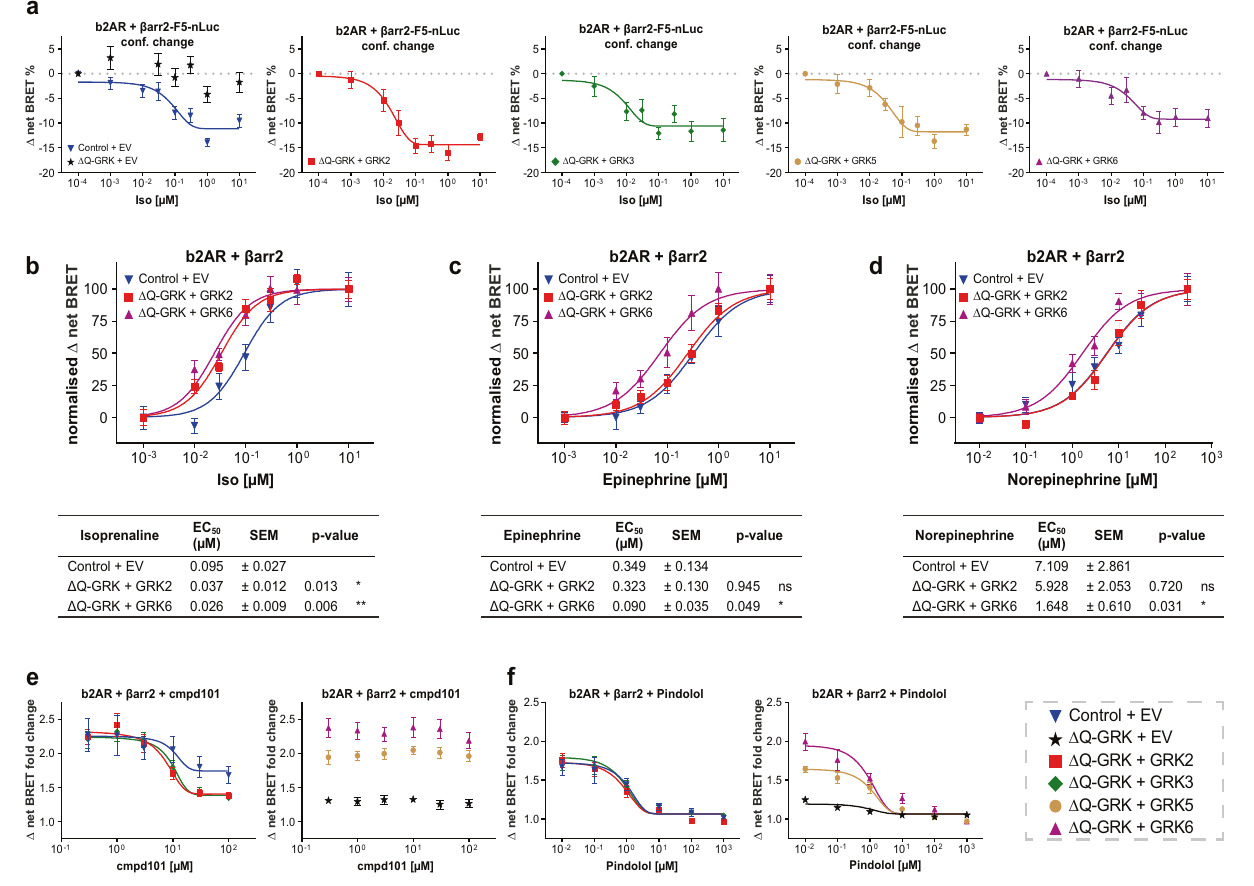
Fig. 2 GRK knockout cells are a viable cellular platform to assess various features of b2AR – β -arrestin complex formation. a Analysis of β -arrestin2 ( β arr2) conformational changes. Δ Q-GRK or Control cells were transfected with an untagged b2AR expression construct and the β arr2-F5-NanoLuc conformational change biosensor (more details on the intramolecular BRET sensor will be published elsewhere), in the absence or presence of GRKs as noted and stimulated with isoprenaline (Iso). Conformational change data are shown as Δ net BRET change in per cent, mean of n = 3 independent repetitions ± SEM. b – d The recruitment of β arr2 to the b2AR following stimulation with Iso ( b ), Epinephrine ( c ) or Norepinephrine ( d ) in presence of all endogenous GRKs or individually overexpressed GRK2 or GRK6 in Δ Q-GRK as indicated. Data are depicted as a mean of n = 3 independent experiments ± SEM and normalised to individual maxima. The tables below depict the EC 50 ± SEM of the corresponding concentration-response curves. The EC 50 of the indicated conditions were compared to the EC 50 in Control using ANOVA and two-sided Dunnett ’ s test (* p < 0.05; ** p < 0.01; ns not signi fi cant). e , f Utilisation of the β arr recruitment assay for speci fi city determination of the GRK inhibitor cmpd101 in living cells. Δ Q-GRK or Control cells were transfected with b2AR-NanoLuc, Halo-Tag- β arr2 and either GRK2, 3, 5, 6 or EV as noted. The cells were incubated with different concentrations of cmpd101 ( e ) or the b2AR antagonist pindolol ( f ) for 10 min prior to stimulation with 1 µ M Iso. The recruitment-induced BRET changes were measured and calculated as Δ net BRET change in per cent, represented as the mean of n = 4 independent experiments ± SEM. All exact p values, test statistics, effect sizes, con fi dence intervals and degrees of freedom are provided in the Source Data fi les. (Fig. 1c). As indicated by the experiments shown in Fig. 3b, and initial traf fi cking) reveals that this interaction translates to Δ GRK cell lines only featuring the expression of GRK5 and/or 6 functional receptor internalisation only in the presence of GRK2 did not increase the β -arrestin2 recruitment to the M5R as in and 3 (Fig. 3e, g). For the PTH1R, we were able to detect ligand- comparison to Δ Q-GRK. induced co-localisation with β -arrestin2 or Rab5 in all conditions Further, we employed confocal live-cell microscopy to assess expressing GRKs (Fig. 3f, h). Interestingly, the agonist-stimulated the dependency of PTH1R and M5R internalisation on PTH1R was still able to induce a slight membrane translocation endogenous GRK levels in Control, Δ GRK2/3 and Δ GRK5/6 as of β -arrestin2 in Δ Q-GRK, con fi rming the GRK-independent well as in Δ Q-GRK. Under basal conditions, β -arrestin2 is located af fi nity of β -arrestin2 toward the ligand-activated receptor in the cytosol, M5R and PTH1R in the cell membrane and Rab5 (Fig. 3d). The results obtained for the PTH1R using endogenous (early endosome marker) in endosomes (Fig. 3e, f basal). As GRK expression were veri fi ed in a reciprocal experiment expected, the M5R was not able to induce β -arrestin2 transloca- overexpressing single GRKs in Δ Q-GRK for β -arrestin1 and 2 tion in the absence of GRK2 and 3 ( Δ GRK2/3 and Δ Q-GRK) (Supplementary Fig. 7c – f). (Fig. 3e). These apparent differences in GRK-speci fi c β -arrestin recruitment, as exempli fi ed by the M5R and the PTH1R, were encountered The quanti fi cation of co-localisation between the M5R and β - multiple times during our analysis across twelve different GPCRs arrestin2 (Fig. 3g) con fi rms our fi ndings of Fig. 3b and (Supplementary Fig. 5). Via statistical multiple comparisons of BRET Supplementary Fig. 7a. Analysis of M5R co-localisation with fold changes at saturating ligand concentrations for each of the tested Rab5 (as a surrogate measurement for receptor internalisation NATURE COMMUNICATIONS| (2022) 13:540